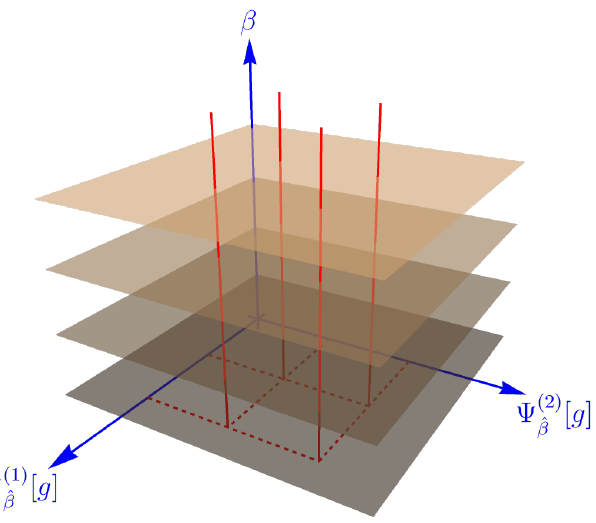
Figure 1 . An illustration of how we organize the space of bulk metrics G R . The horizontal surfaces are codimension-1 slices of constant β . The red lines are 1-dimensional surfaces that define a notion of what it means to keep ‘the rest of the metric’ constant while changing β , and can thus be said to define additional coordinates on the space of all metrics. We may in particular proceed by choosing a reference value ˆ β and lifting any coordinates Ψ p 1 q , Ψ p 2 q on the corresponding horizontal surface to the full space by taking them to be constant along the red lines. We use Ψ ˆ of inverting this procedure by taking a general metric g and ‘projecting’ it along the red lines into the horizontal surface at ˆ β